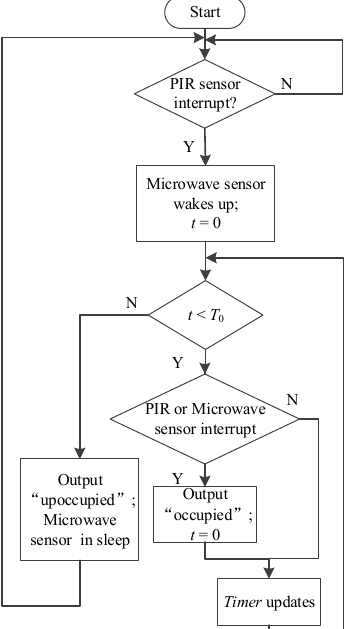
Figure 4. Flowchart of the data fusion method with passive infrared (PIR) and microwave sensors.